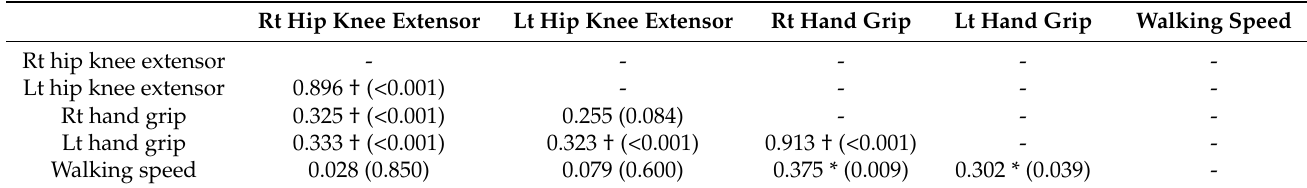
Table 5. Correlation among muscle strength analysis (r, Pearson correlation) ( n =